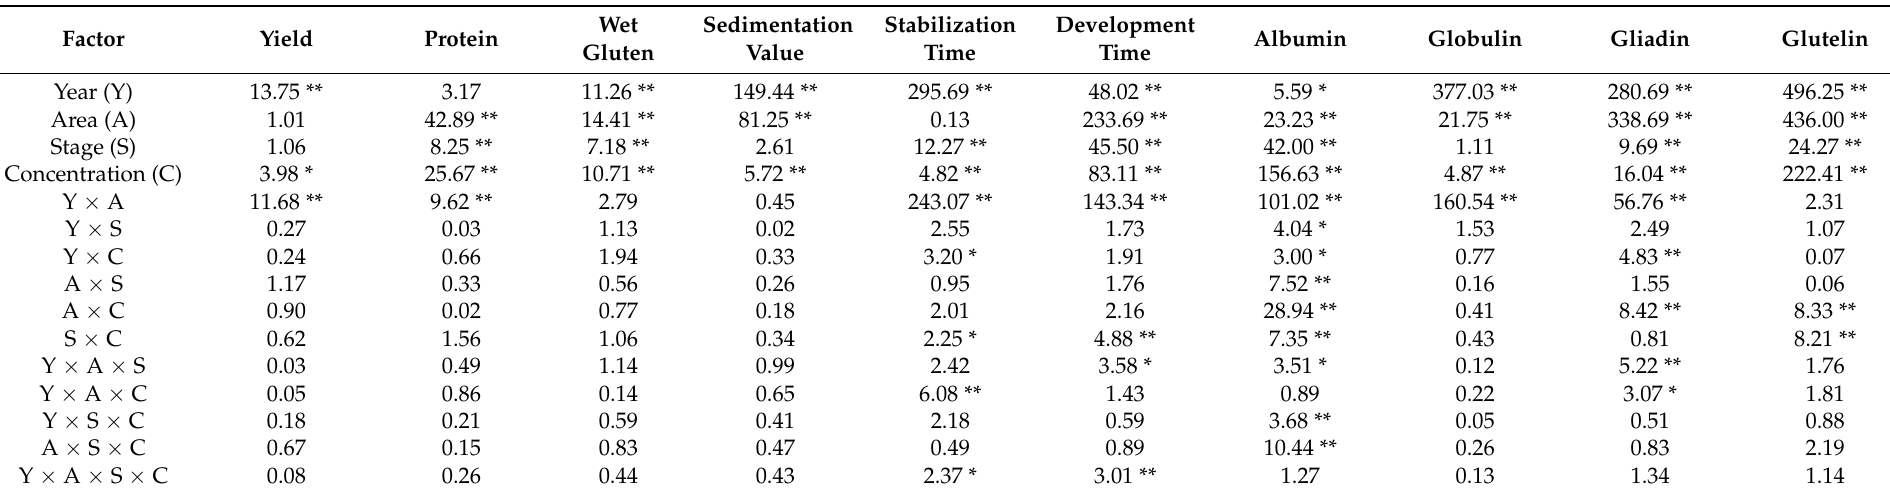
Table 3. Variance analysis of the effects of year, experimental site, and foliar application stage and concentration of potassium fertilizer on yield, protein and components, wet gluten, sedimentation value, and rheological properties of dough of wheat